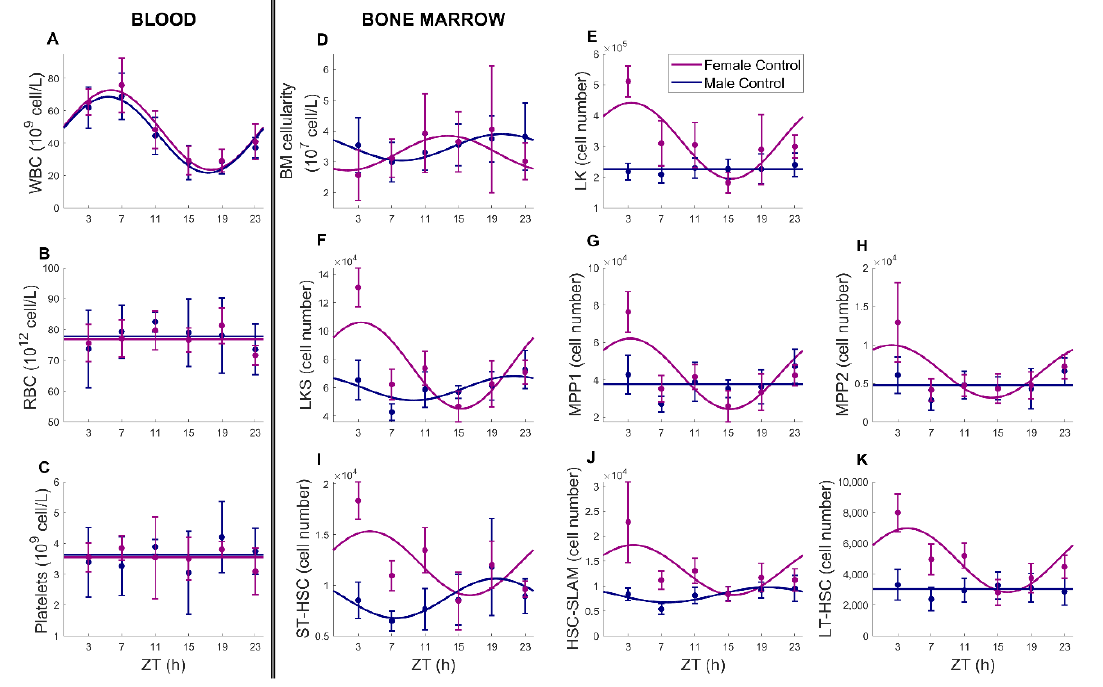
Figure 3. Sex- and timing-dependent blood and bone marrow cell counts in control animals ( A – C ) Circulating blood cells, ( D ) bone marrow cellularity ( E – K ) bone marrow immature progenitors. Dots represent raw data (mean ± SD) and solid lines are the best-fit cosinor curves. Table 1. Cosinor parameters related to WBC, BM cellularity and progenitor counts, in physiological and treated conditions.